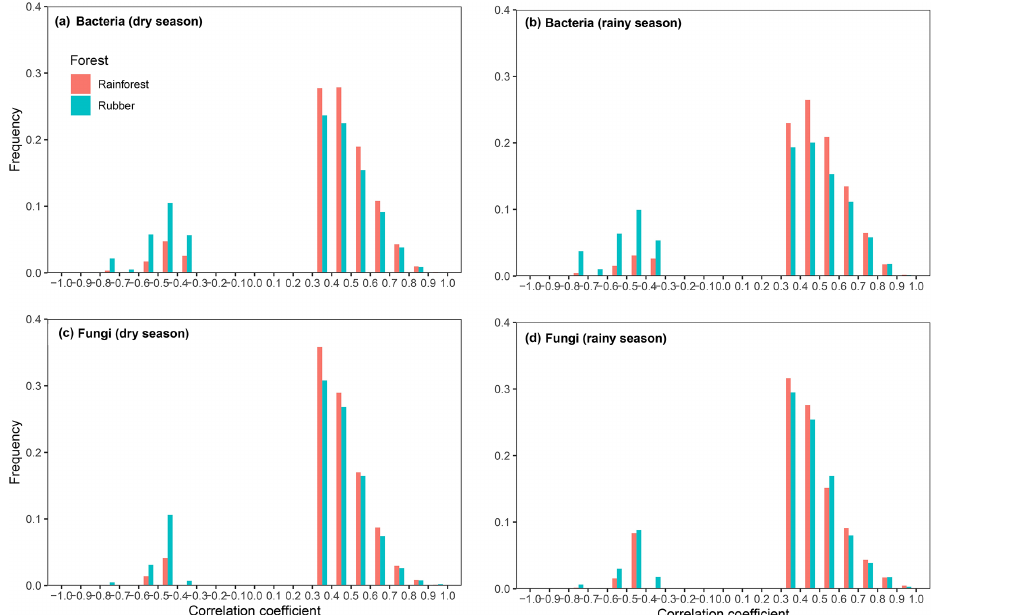
Figure 6. Frequency distributions of the correlation strength in bacterial ( a – dry season, b – rainy season) and fungal ( c – dry season, d – rainy season) networks of rubber plantations and tropical rainforests in the dry and rainy seasons (absolute correlation coefficient greater than 0.3, P < 0 . 01). Correlations in rainforest networks are red, and correlations in rubber plantation networks are blue.